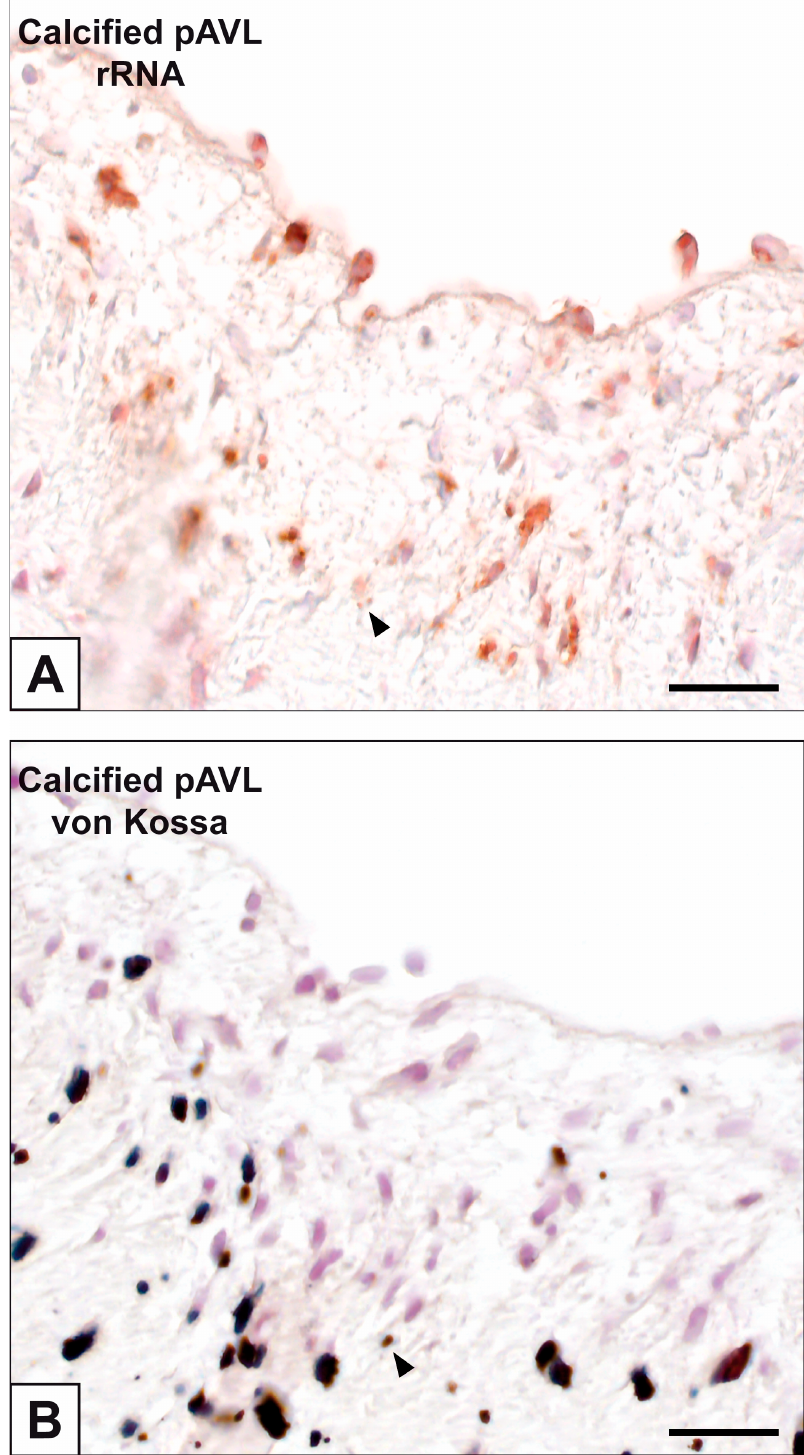
Figure 3. Immunohistochemical detection of rRNA in porcine aortic valve leaflets (pAVLs) after 7-day- long implantation in rat subcutis . ( A ) Immunopositivity of residual endothelial cells and mineralizing pAVICs as well as cell debris (arrowhead) in the tunica fibrosa . ( B ) Paraserial section showing positivity to von Kossa staining of mineralizing pAVICs and cell debris (arrowhead). Bar: 0.25 mm.